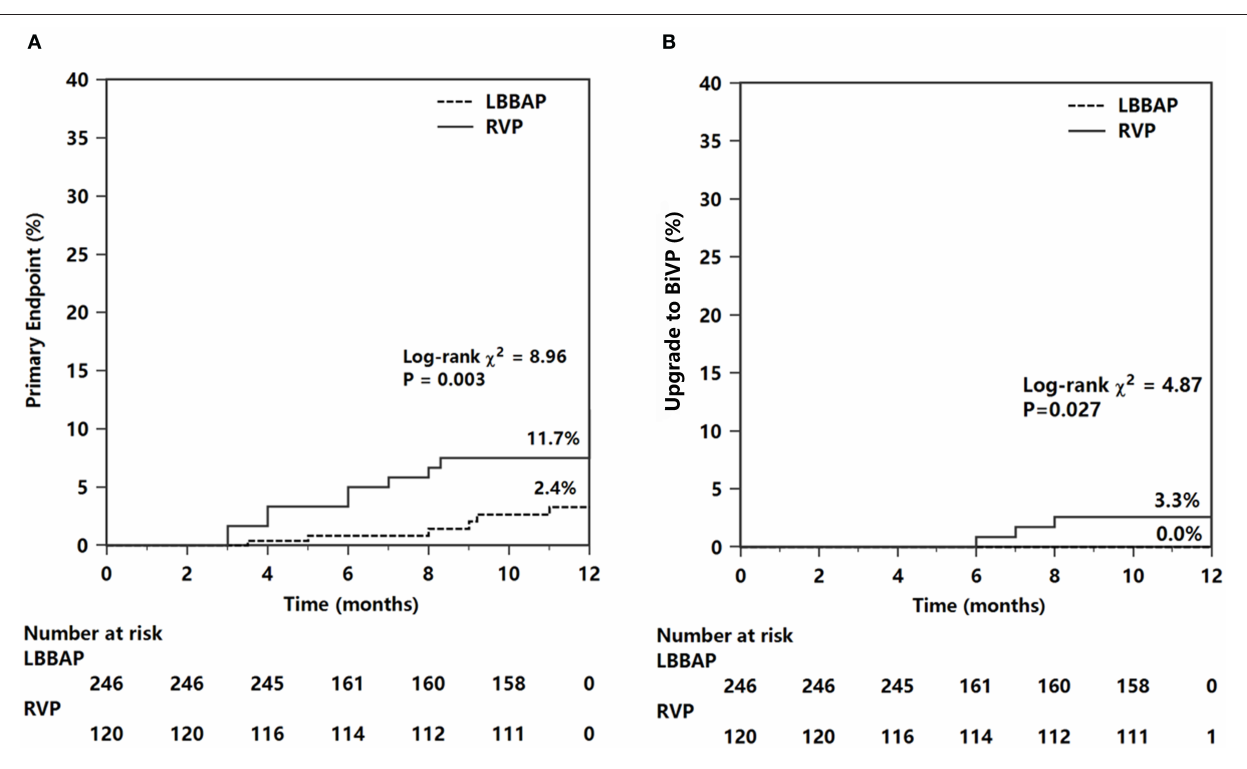
FIGURE 3 | Kaplan–Meier survival curves and analysis of the primary endpoint (A) and endpoint of upgrade to BiVP (B) . For abbreviations, see Figure 1 .